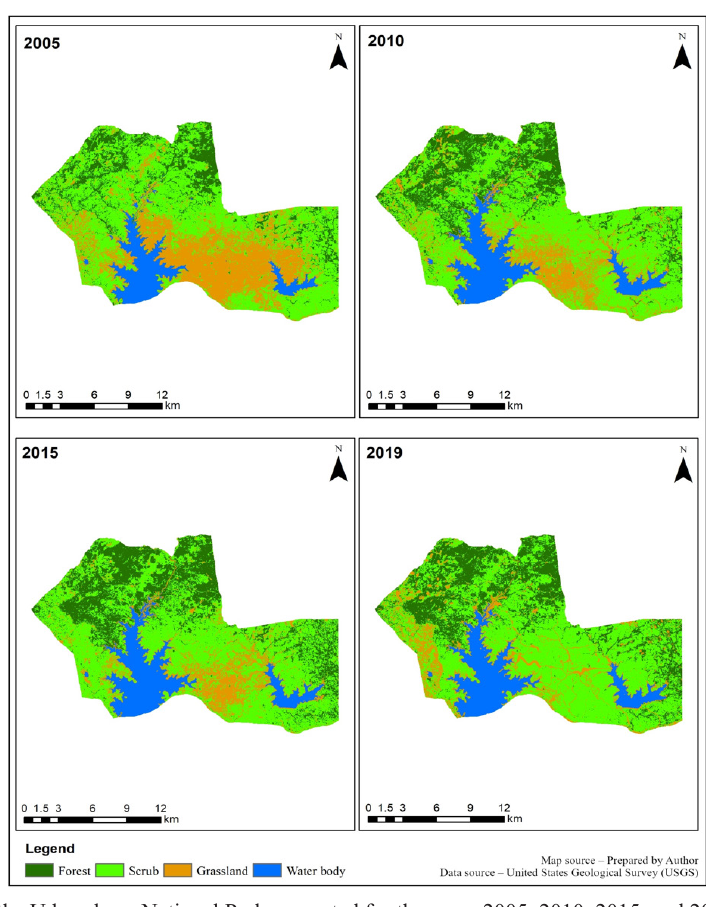
Figure 3 : Habitat maps of the Udawalawe National Park generated for the years 2005, 2010, 2015, and 2019.